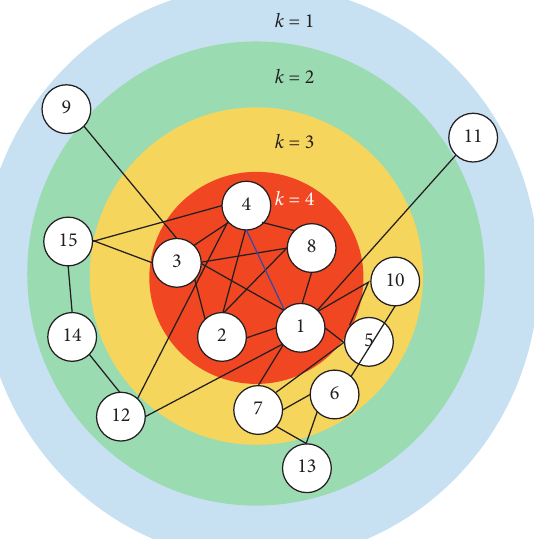
Figure 1: A k -shell layered diagram. Nodes 1, 2, 3, 4, and 8 are in the 4-shell; nodes 5, 6, 7, and 10 are in the 3-shell; nodes 12, 13, 14, and 15 are in the 2-shell, and the rest are in the 1-shell.